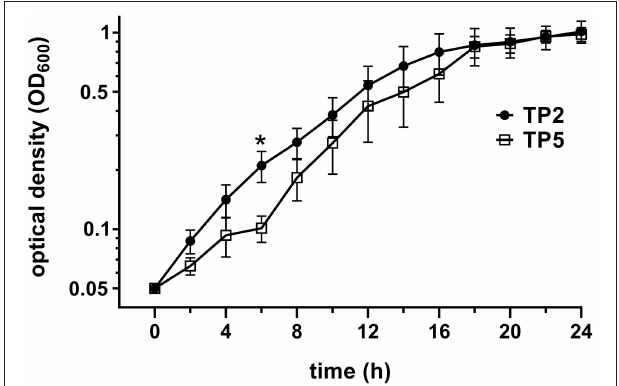
FIGURE 1 | Comparison of standard growth curves of TP2 and TP5. Standard growth curves were generated by measuring OD 600 by spectrophotometer every 2 h for 24 h. Data are presented as mean ± SEM of OD 600 readings for 5 different inocula for each strain. Asterisk indicates a significant difference ( P < 0.05) between the two strains at that time